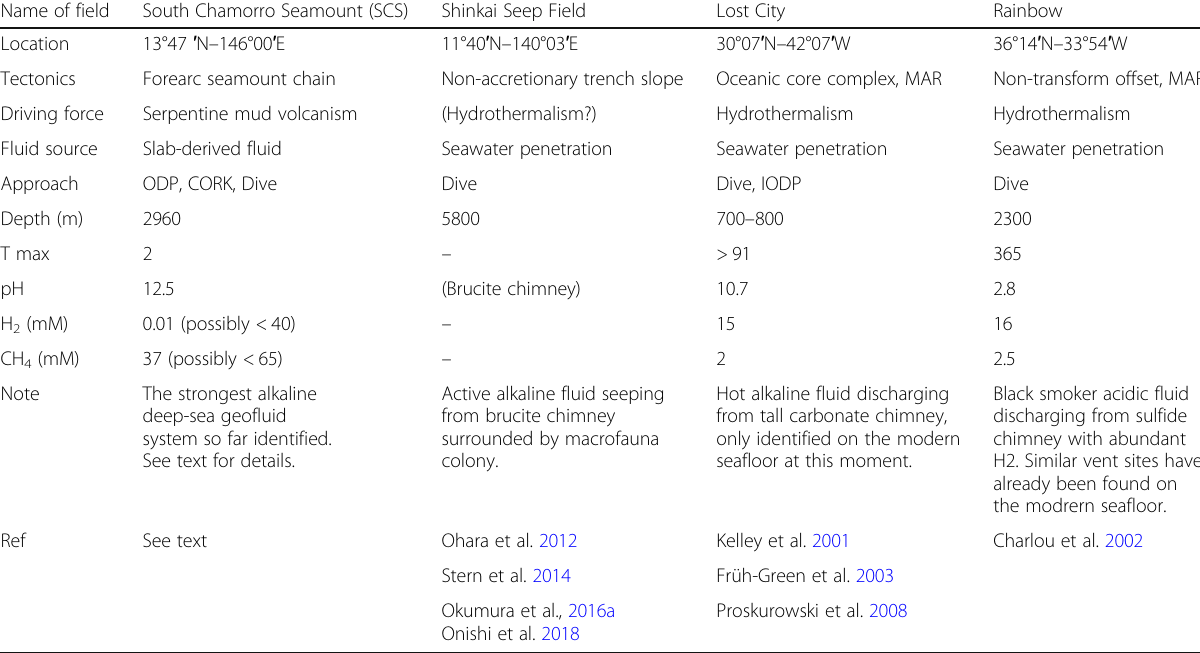
Table 1 Deep-sea serpentinization-associated geofluid fields Name of